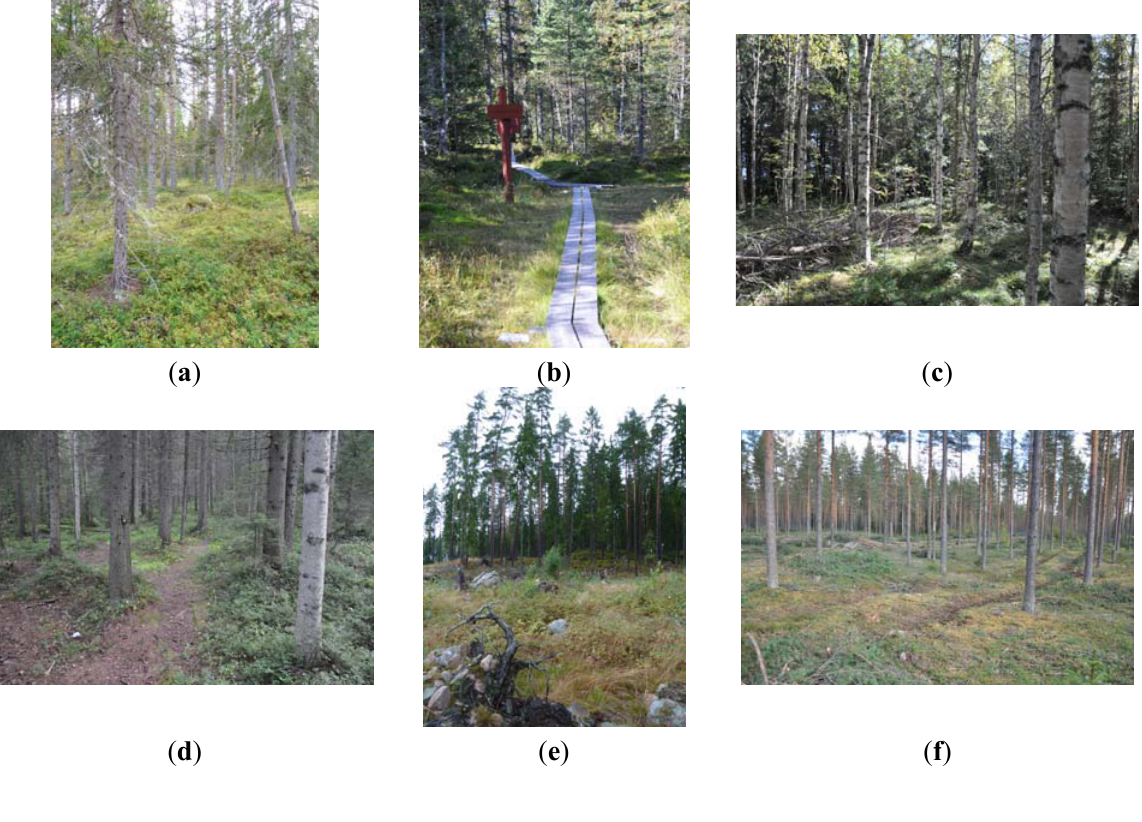
Figure 1. Examples of forest scenes included in the study: ( a ) natural-looking, low biodiversity (coniferous); ( b ) recreation, low biodiversity (coniferous); ( c ) natural-looking, high biodiversity (mixed); ( d ) recreation, high biodiversity (mixed); ( e ) forest management: clear cut; ( f ) forest management: traces of forest